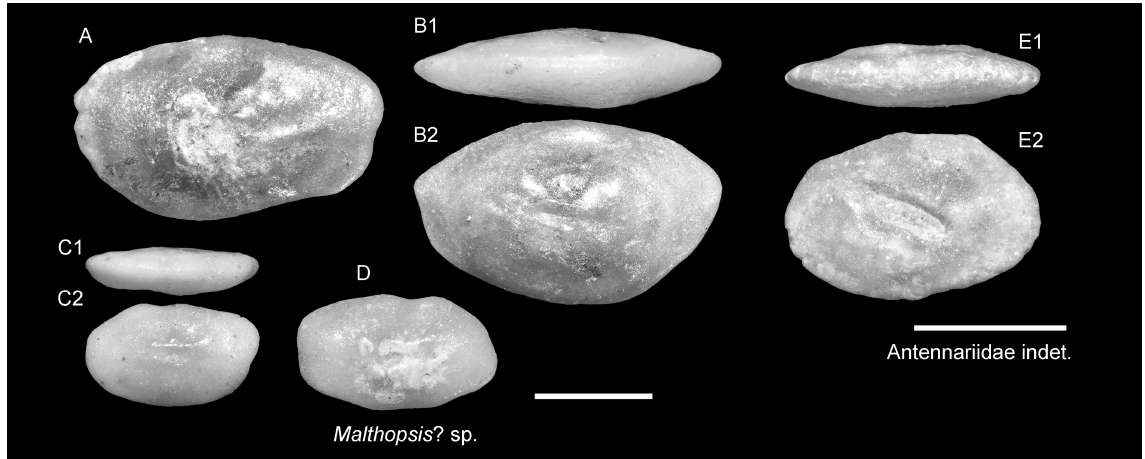
Fig. 37. Fish otoliths from the US middle and upper Eocene. A–D . Malthopsis ? sp. A . Landrum M.,